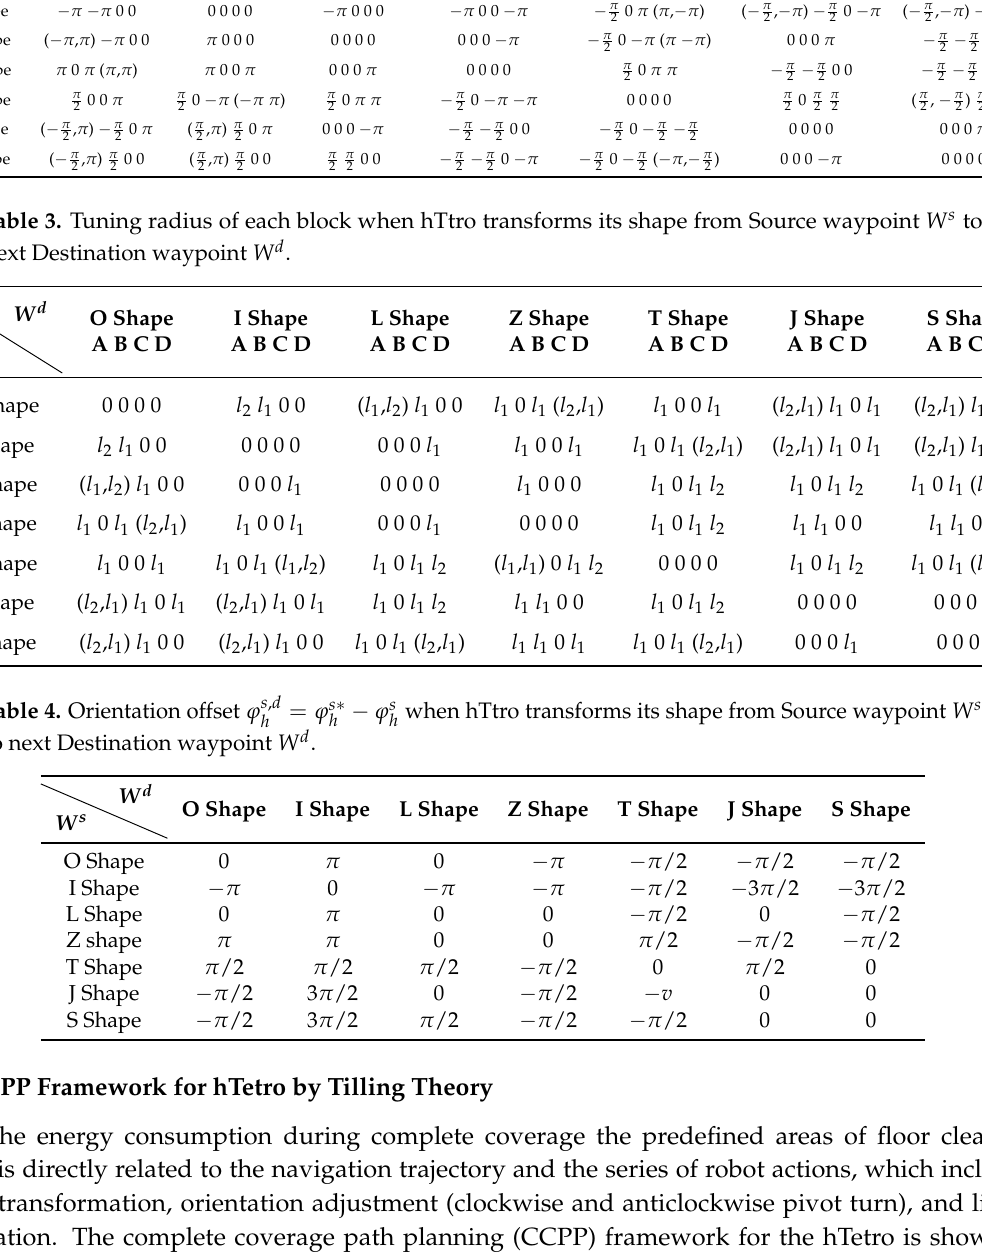
Table 2. Turning angle θ i of each block when hTtro transforms shape from Source waypoint W s to next Destination waypoint W d .